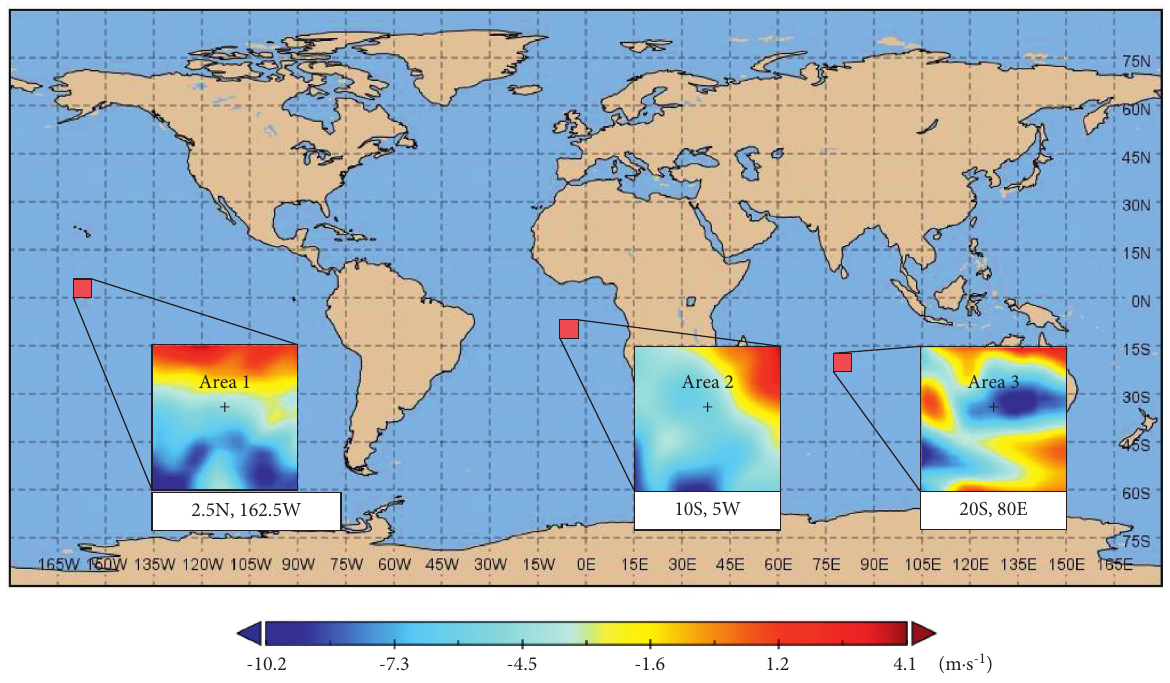
Figure 6: Coordinates of three areas and their surroundings on the map. Table 2: Statistical indices of three sea